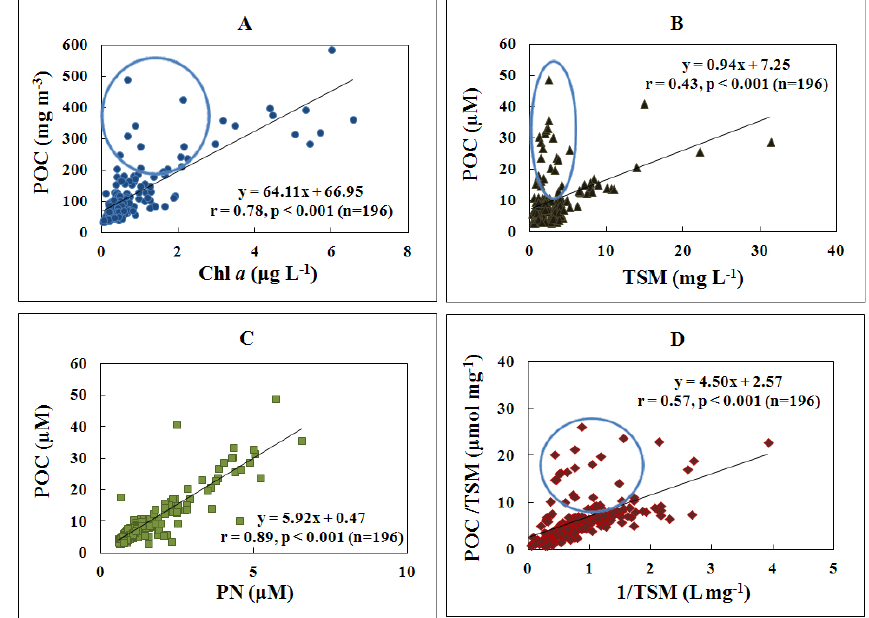
Fig. 4. Relationships between POC and Chl a (A) ; POC and TSM (B) ; POC and PN (C) ; POC/TSM and 1/TSM (D) in the ECS.